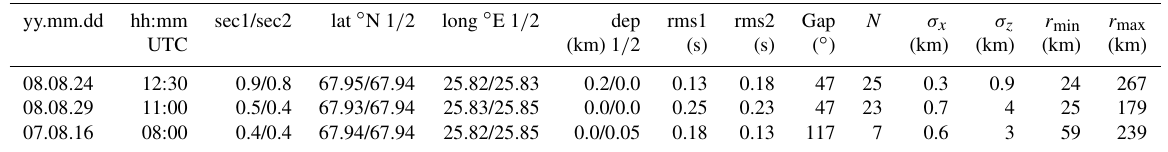
Figure 3. Seismograms of explosion on 16 August 2007 at 08:00UTC, 67.93 ◦ N, 25.82 ◦ E ML = 1.5 (FENCAT) from Hukkavaara hill. Traces are normalised to maximum amplitude. Table 2. Results of Hukkavaara explosions location with the HYPOELLIPS method (index 1) and the grid search method (index 2). Sec1/2 is the final source time defined by HYPOELLIPS/grid search method, lat1/2 (long1/2) is the final latitude (longitude) defined by HYPOEL- LIPS/grid search method. Dep1/2 is the depth defined by HYPOELLIPS/grid search method, rms1 is the final HYPOELLIPS root mean square residual, rms2 is the final grid search method rms, N is the number of POLENET/LAPNET stations used, σ x and σ z are the horizon- tal and vertical uncertainties at the 68% confidence level, r min is the epicentre distance to the nearest station, r max is the epicentre distance to the most remote